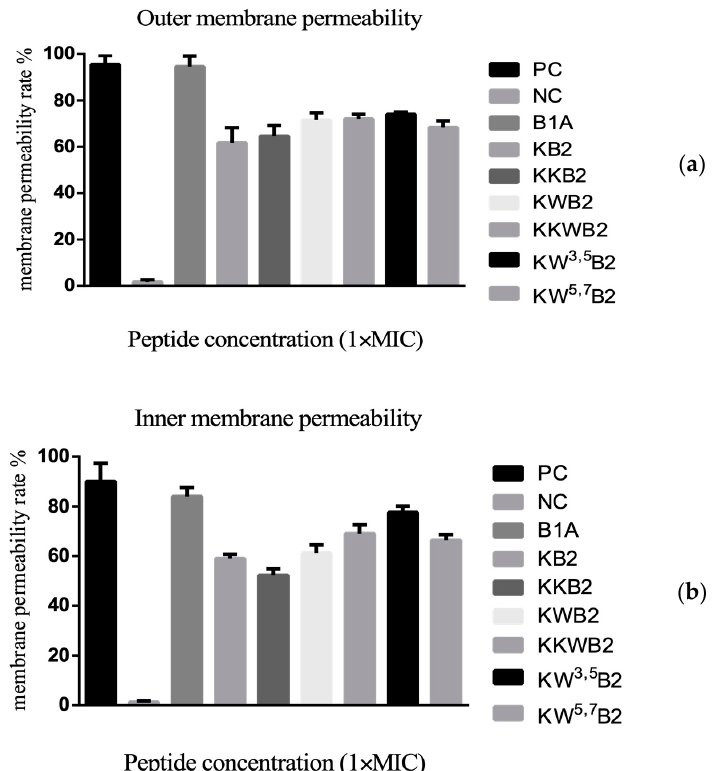
Figure 6. ( a ) Outer membrane permeabilisation assays of E. coli by B1A and six analogues of B1A2 as indicated by the enhanced uptake of NPN. HEPES and EDTA were used as negative control (NC) and positive control (PC), respectively. ( b ) Inter membrane permeabilisation assays of E. coli by B1A and six analogues of B1A2. PBS and 32 µM Melittin were used as negative control (NC) and positive control (PC), respectively. Data represent means ± SD of five replicates.